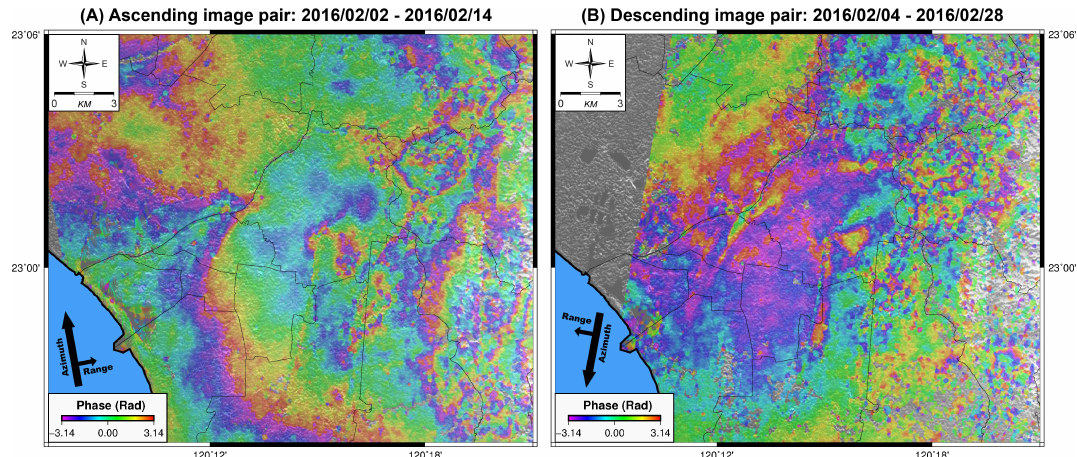
Figure 2. Coseismic interferometric results in Tainan City. ( A ) The results of ascending image pairs. The master image 2016/02/02, and the slave image was 2016/02/14. ( B ) The results of descending image pairs. The master image was 2016/02/04, and the slave image was 2016/02/28. There are some small and clear fringes (diameters are from 1 km–3 km) that exist in study area. The time format of acquisition for the SAR image is provided as YYYY/MM/DD. Table 1. The information of preseismic and coseismic image pairs for the study. Orbit Direction Pair Type Master Slave Days Bperp (m)